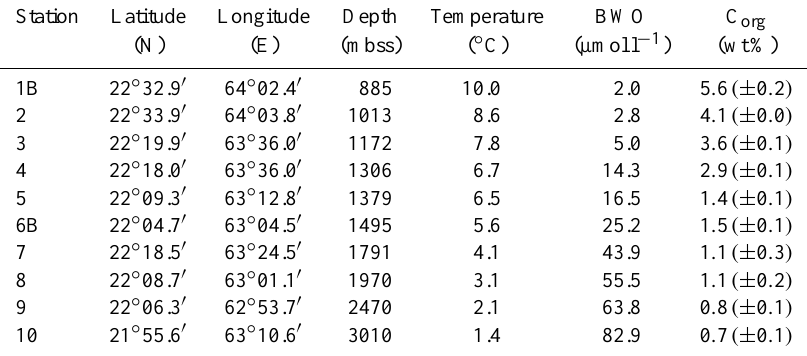
Table 1. Site characteristics. Temperature and bottom water oxygen (BWO) concentrations are derived from CTD data. Depth unit mbss is meters below sea surface. Total organic carbon (C org ) is the average in the top 2cm ( n = 4), with standard deviation between parentheses. Station Latitude Longitude Depth Temperature BWO